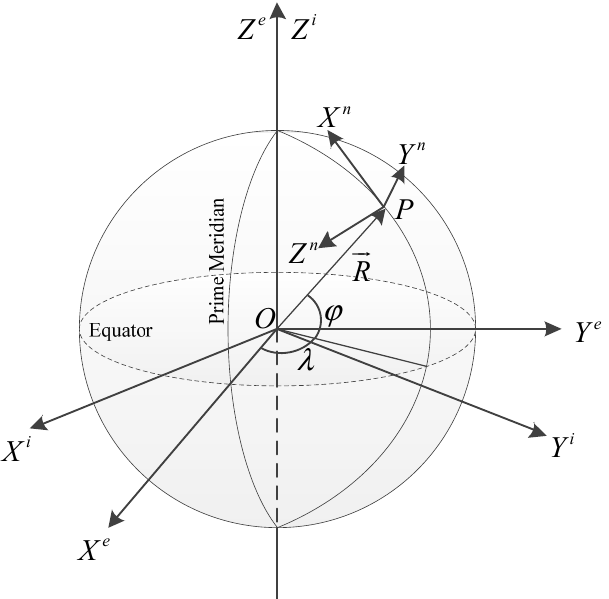
Figure 1. Inertial frame, earth frame and navigation frame representation on the Earth